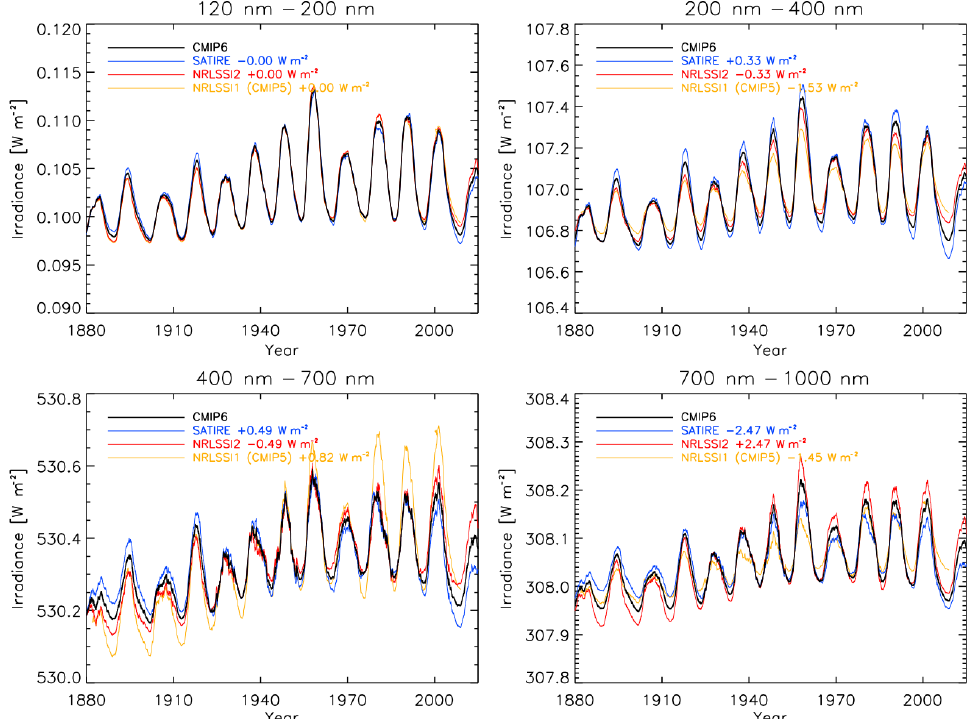
Figure 2. SSI time series from 1882 to 2014, integrated over following wavelength ranges: 120–200nm (top left), 200–400nm (top right), 400–700nm (bottom left), and 700–1000nm (bottom right). An offset, indicated in the legend, has been added to each time series, to ease visualization. All time series are running averages over 2